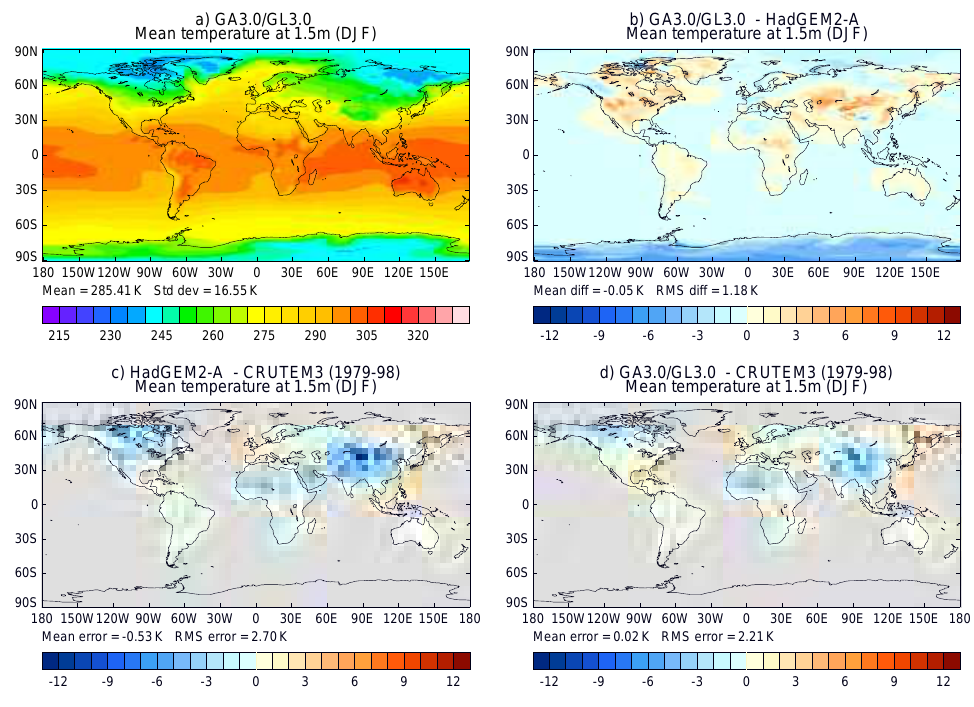
Fig. 4. Climatological 1.5 m temperatures during DJF in the 30 year N96 simulation using the same format as Fig. 3.